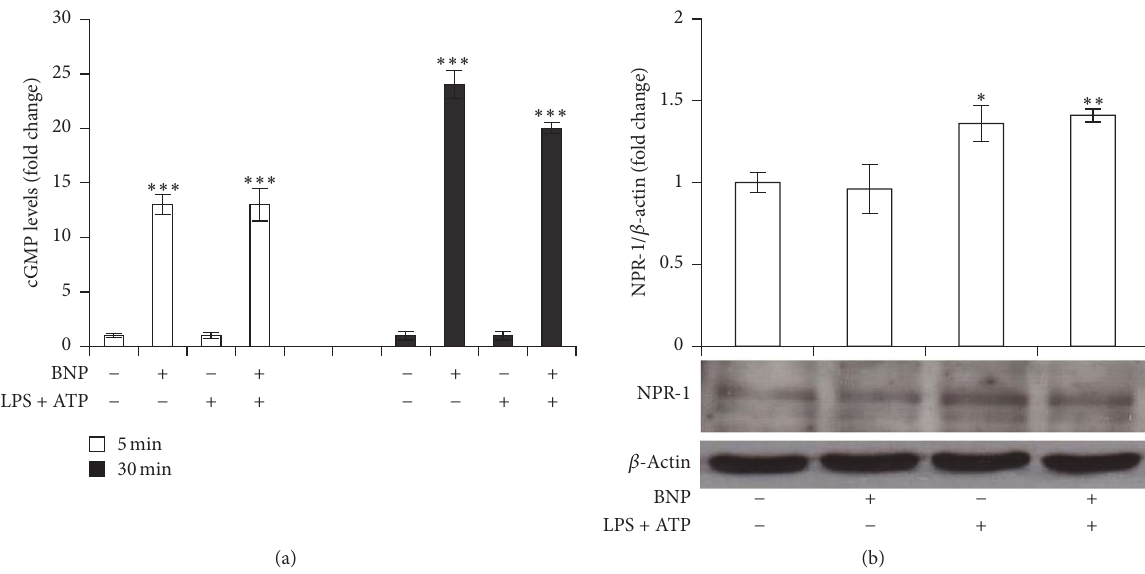
Figure 2: BNP activates NPR-1 in THP-1 cells. (a) THP-1 cells were treated with 10 −8 M BNP in absence or presence of 10 𝜇 g/mL LPS/5mM ATP and cGMP intracellular levels were evaluated after 5 and 30 min treatment. (b) THP-1 cells were treated with 10 −8 M BNP in absence or presence of 10 𝜇 g/mL LPS/5 mM ATP for 30 min. Cell lysates were immunoblotted for NPR-1. The blots were stripped of the bound Ab and reprobed with mouse anti- 𝛽 -actin, to confirm equal loading. Western blots are representative of three separate experiments. Histograms indicate means ± SD of three separate experiments each one tested in triplicate. ∗ 𝑃 < 0.05 , ∗∗ 𝑃 < 0.01 , and ∗∗∗ 𝑃 < 0.001 versus untreated